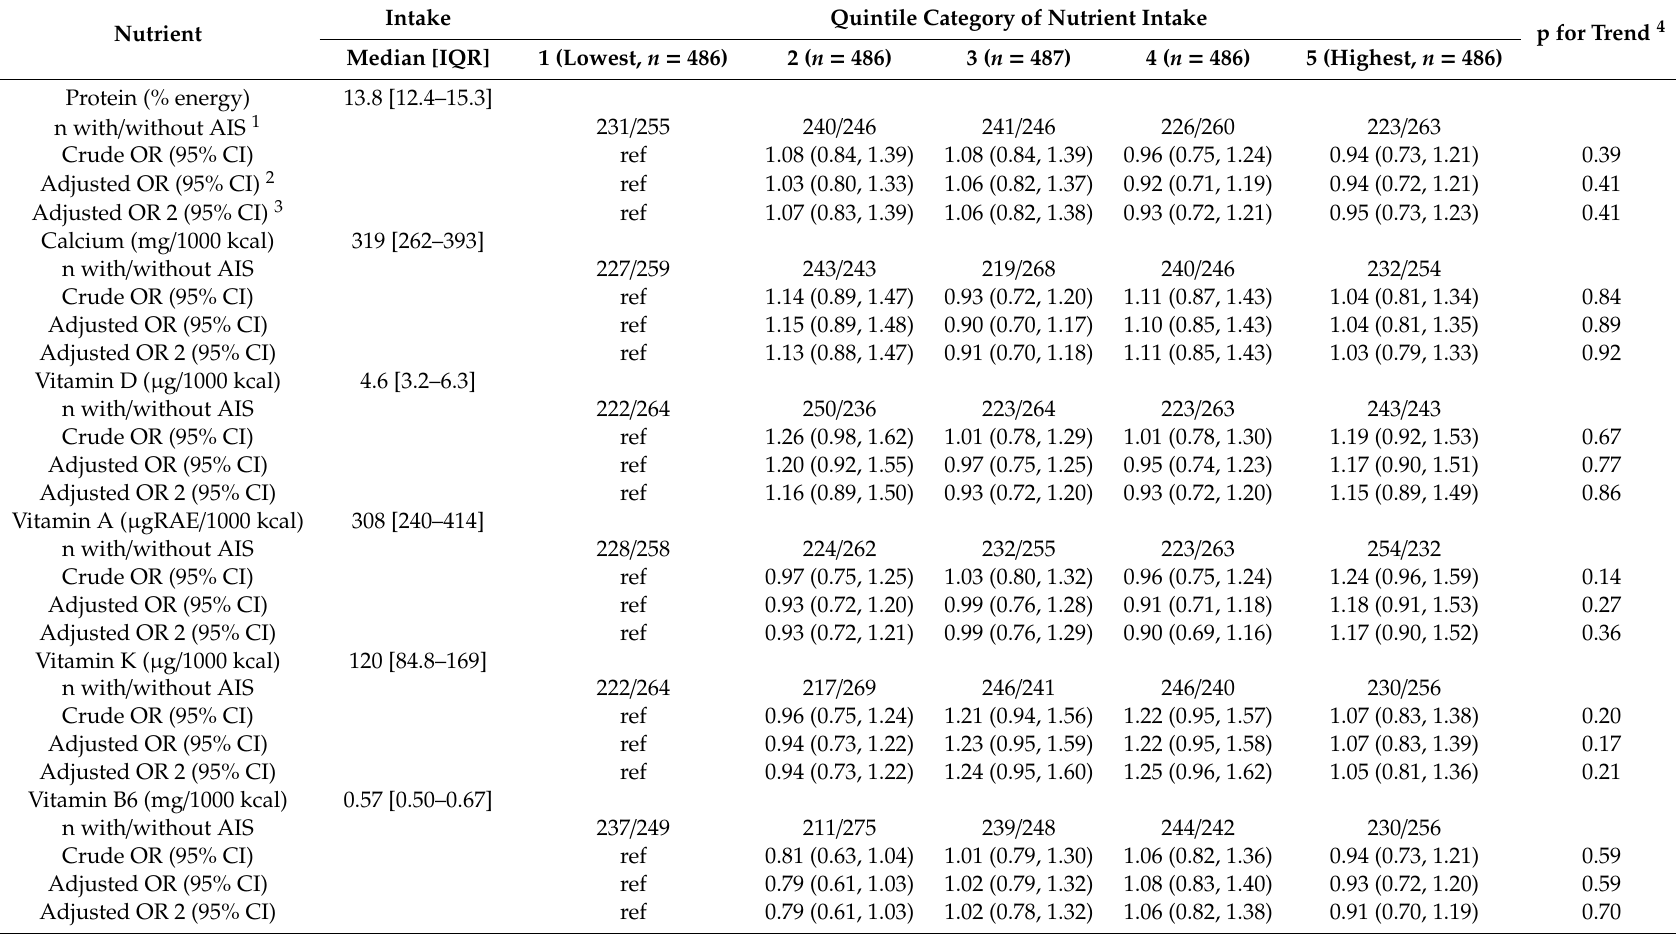
Table 2. Multivariate-adjusted odds ratios and 95% confidence intervals for adolescent idiopathic scoliosis by quintile of nutrient intake in 2431 Japanese female junior high school